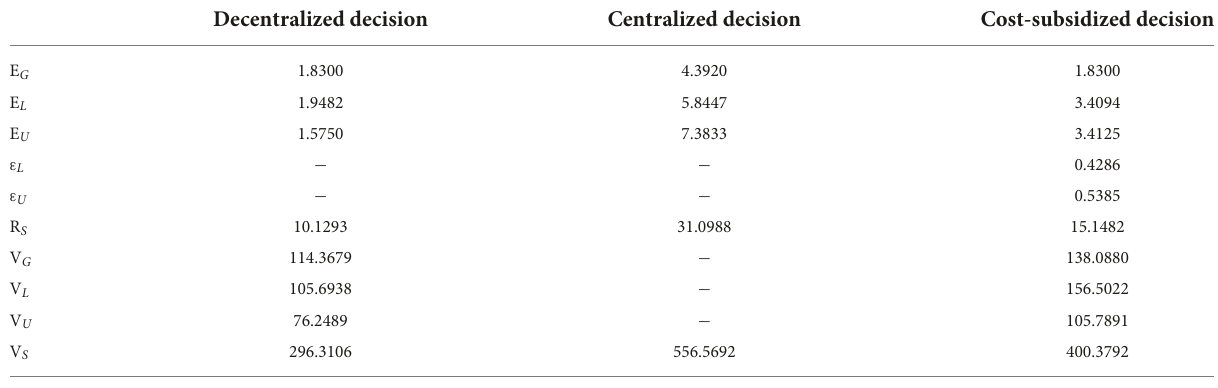
TABLE 4 Equilibrium results of the differential game model in scenarios of decentralized, centralized, and cost-subsidized decision-making.